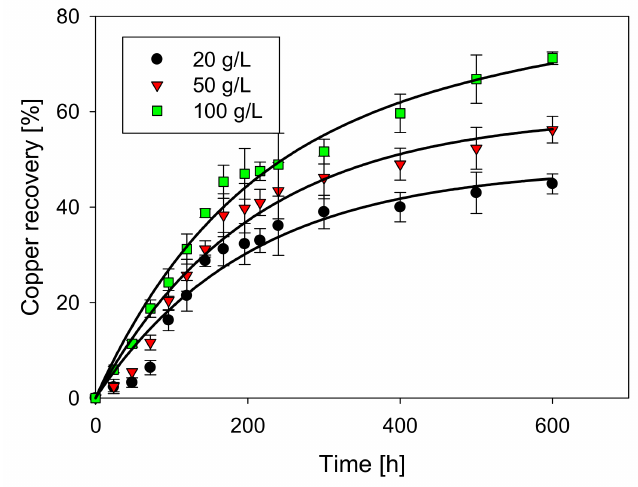
Figure 5. Extraction of Cu (%) vs. time (h), depending on the addition of